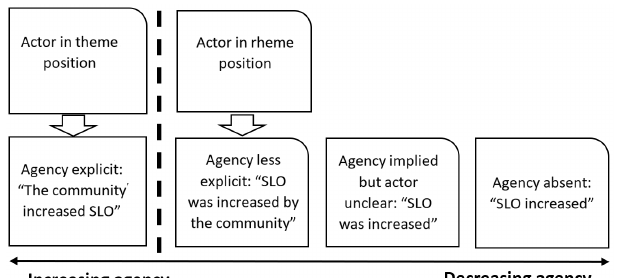
Fig. 1 . Method to determine agency. SLO = social license to